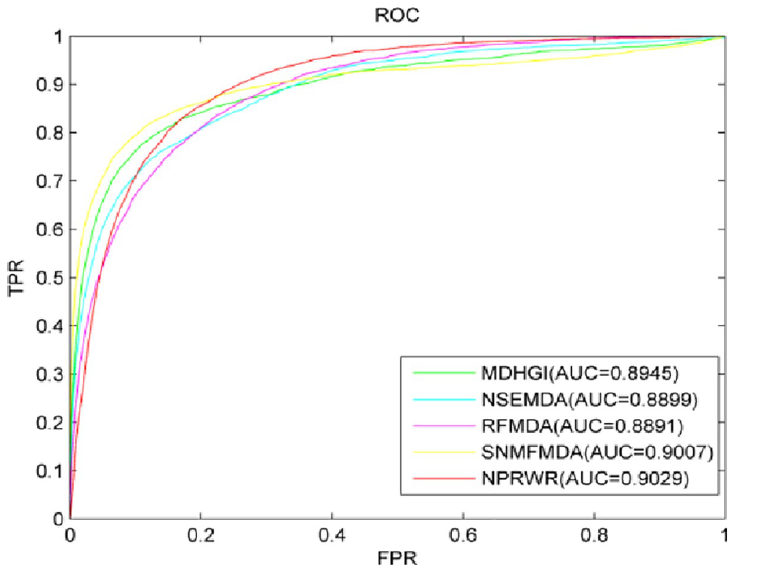
Fig 3. ROC curves and AUC values of NPRWR and other five methods.